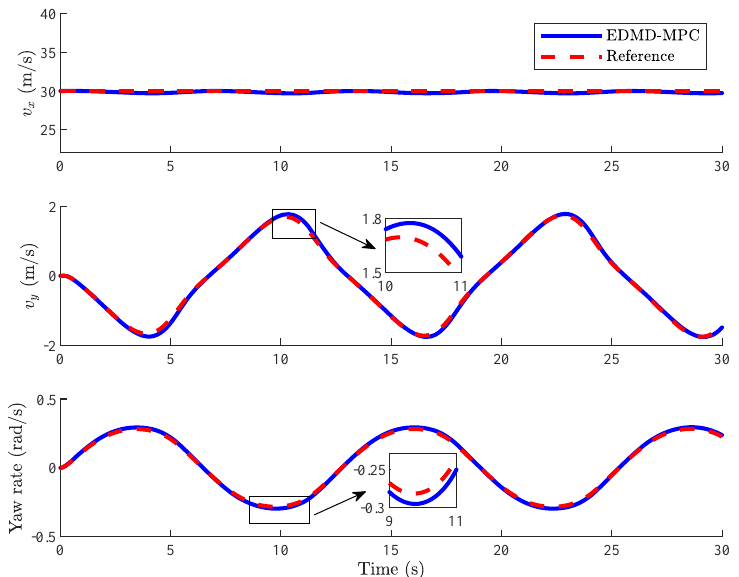
Figure 16. State evolution of EDMD-MPC (Case